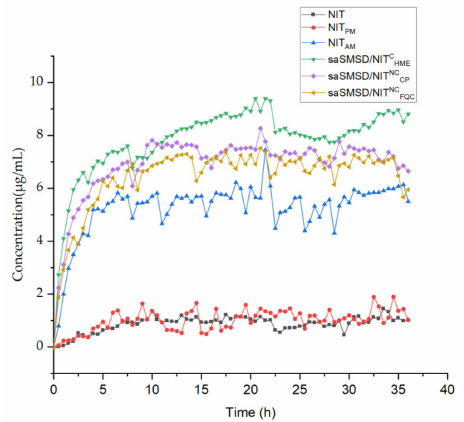
Figure 7. “Spring-parachute” profile of NIT-related samplesincluding NIT, NIT PM , NIT AM , saSMSD/ NIT NC FQC , saSMSD/ NIT NC CP , saSMSD/ NIT C HME during 36 h at the equivalence of 30 mg NIT in PBS (pH 6.8) using dissolution